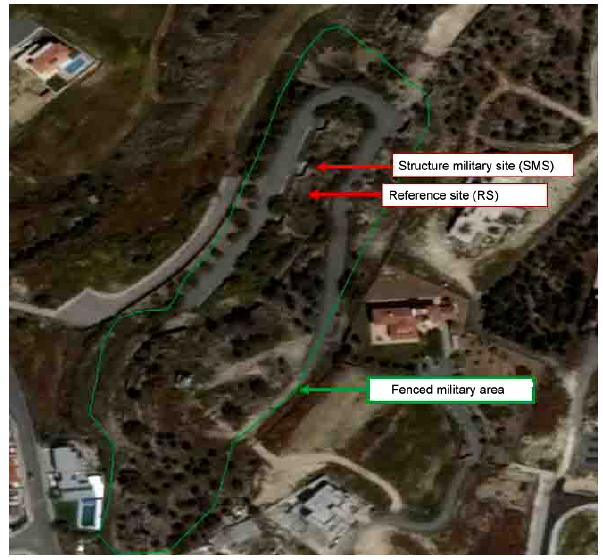
Figure 1. The test area.